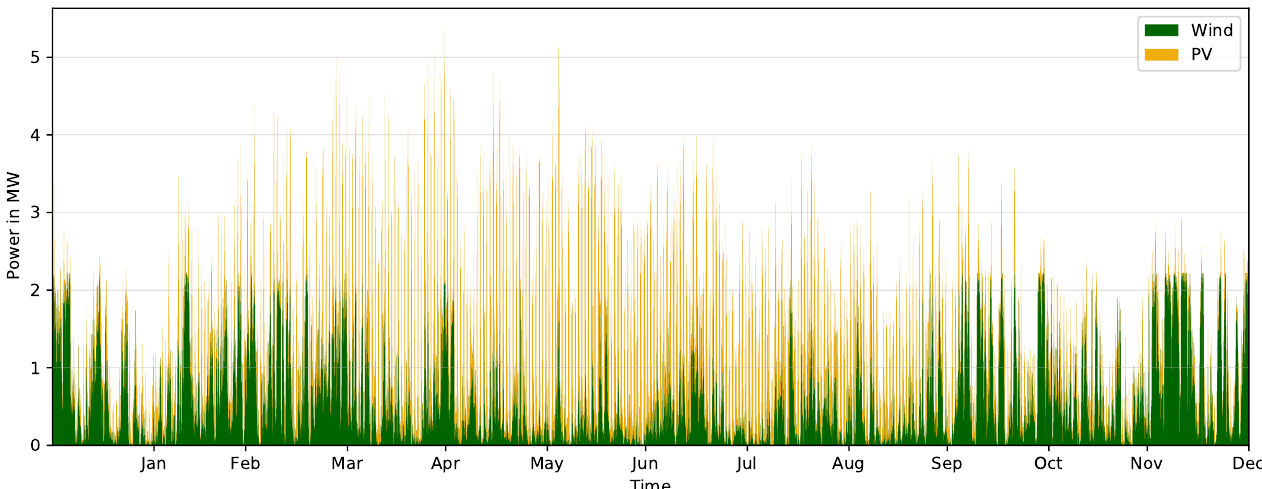
Figure 13. Calculated generated power of wind power and photovoltaic plants during a test reference year (TRY) at the selected location of the case study (Steinberg am Wald, latitude: 50.404387° longitude: 11.332333°